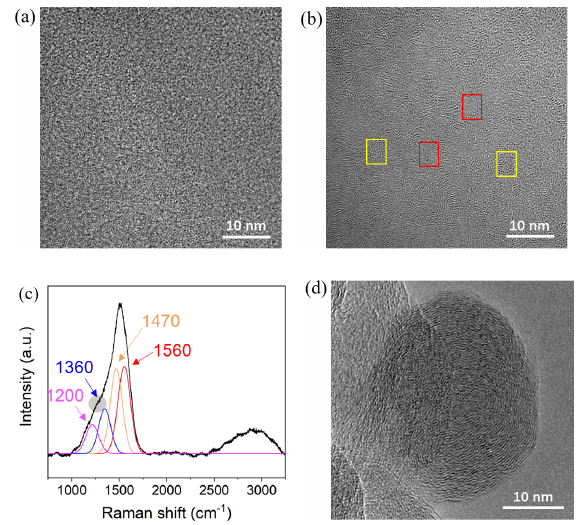
Figure 1. Structural analysis of the FL-C films: ( a ) TEM image of sample 5% H. ( b ) TEM image of sample 20% H, with flat amorphous structures in the red square mark and coarse crystalline structures in the yellow square mark, respectively. ( c ) Raman spectra of the sample 5% H in the range from 750 to 3250 cm − 1 . ( d ) TEM image of extracted fullerene-like structures from wear debris of sample 5%